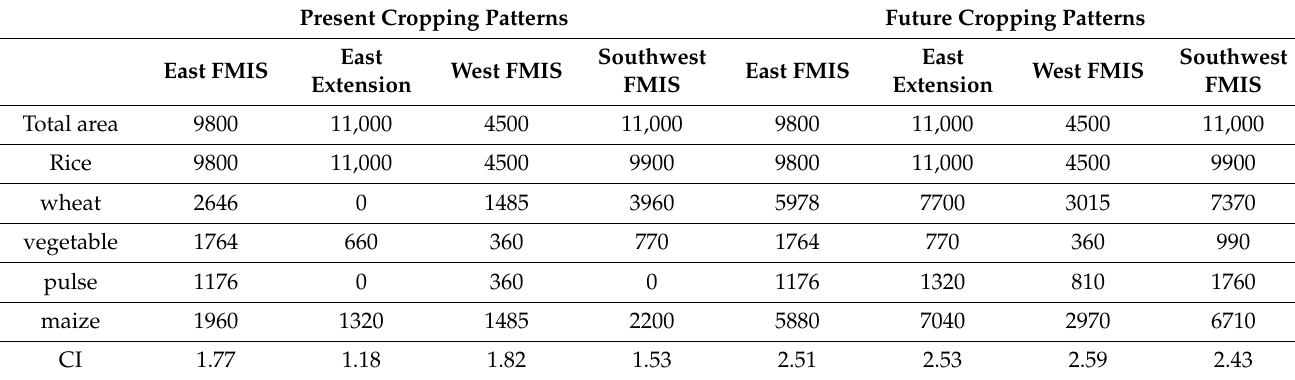
Table 3. Crop area under the current and future conditions in the Babai Irrigation Project (all areas in